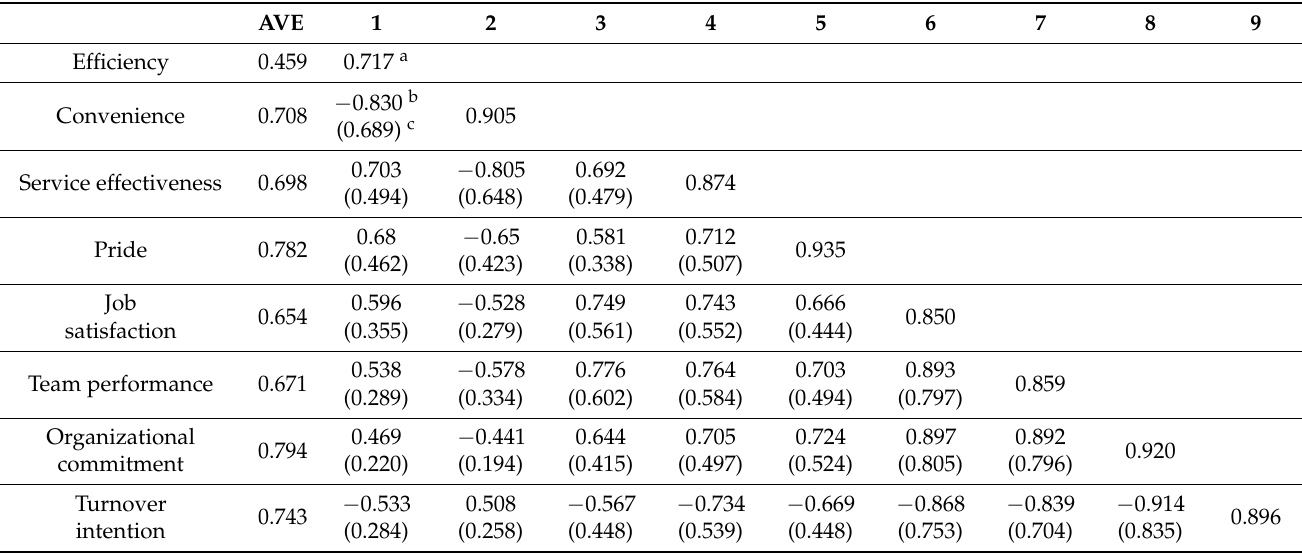
Table 4. Descriptive Statistics and Associated